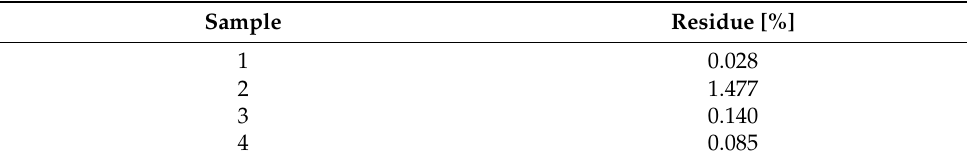
Table 1. Solid residue content of